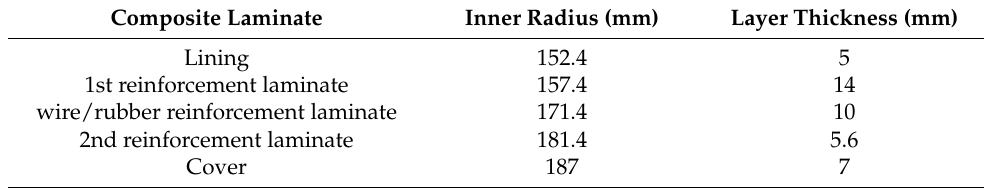
Table 1. Structural parameters of the hose.